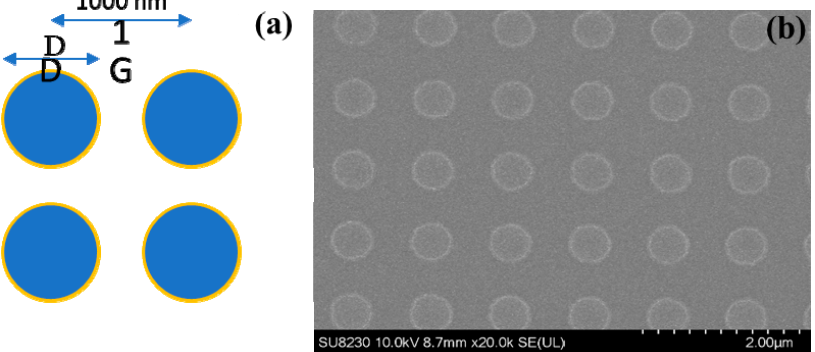
Figure 7. Design patterns of TiO 2 :Nb nanodisk antennas for calculation and fabrication. Periodicity is 1000 nm ( a ). SEM image of TiO 2 :Nb nanodisk structure ( b ).